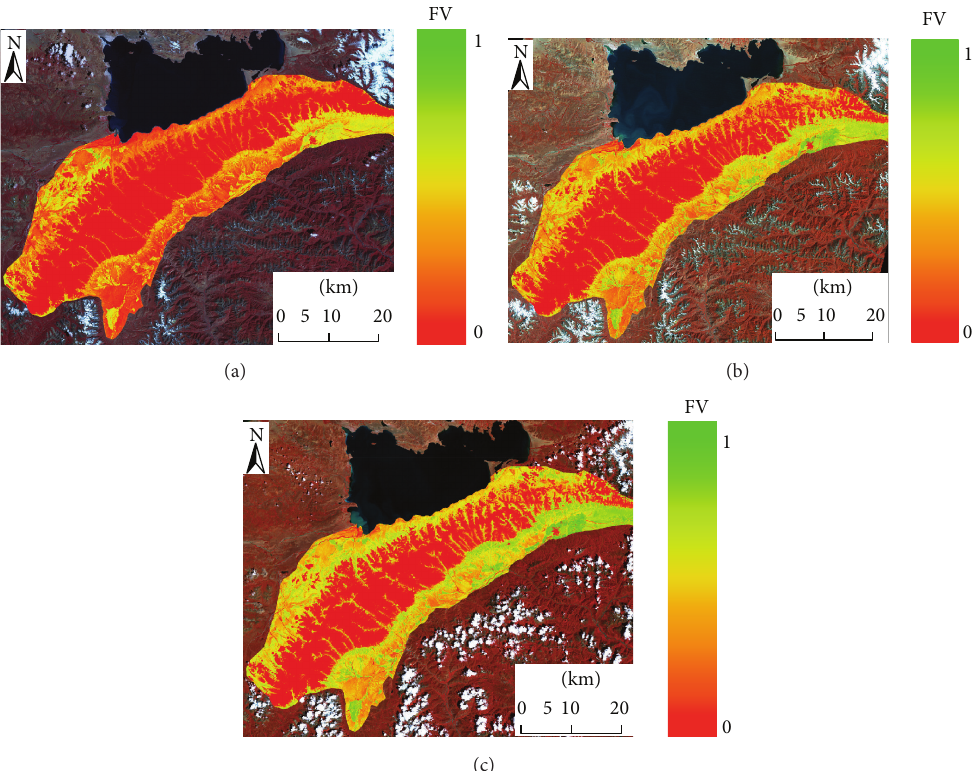
Figure 5: The vegetation fraction maps of the WNR in (a) 1972, (b) 1991, and (c) 2009. The FV values show the percentage of vegetation cover in each pixel (image band composition RGB: 421).